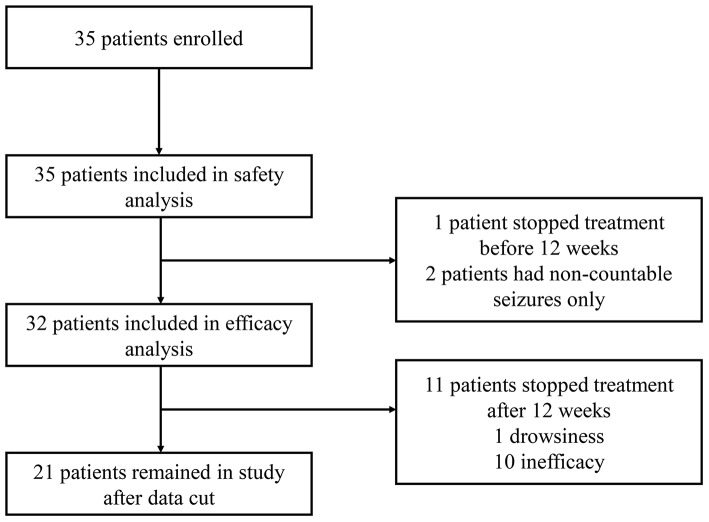
Study participants flow charts.